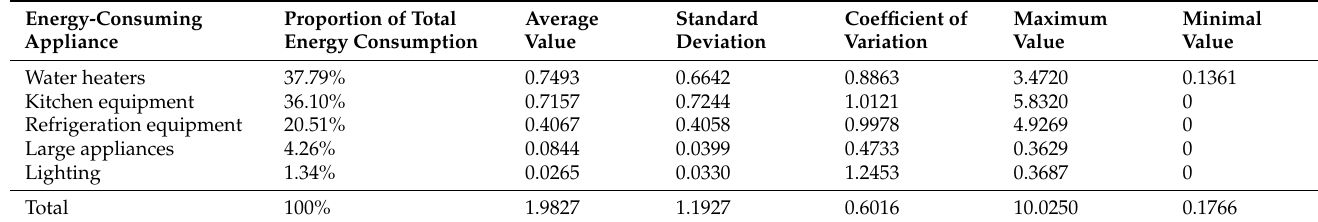
Table 3. Residential energy consumption by equipment type